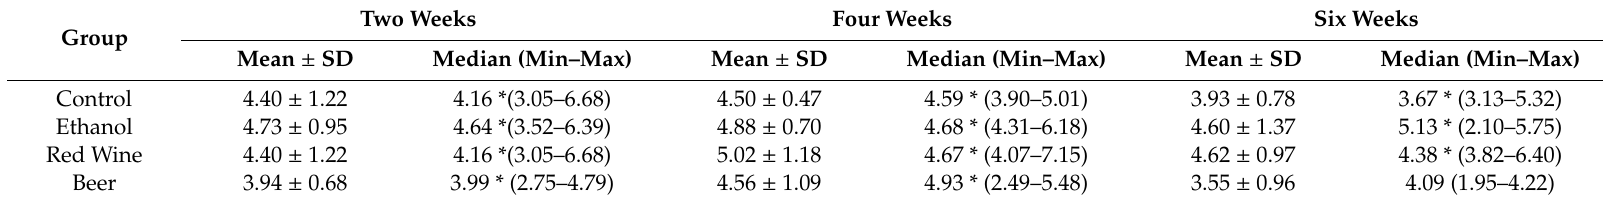
Table 10. Glutathione reductase (GR) activity (per mg of protein) in the groups of experimental rats stratified by a group and experiment